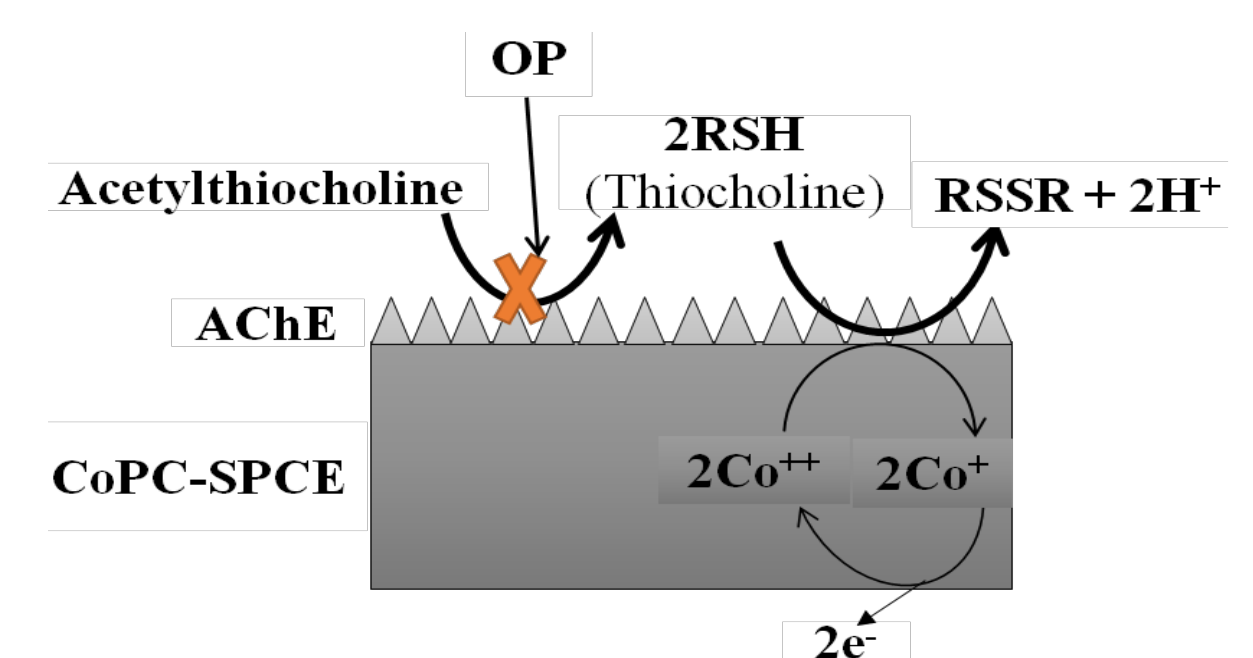
Figure 7. Schematic diagram explaining the principle of the reactions based on this amperometric biosensor. Adapted from Crew et al . [229].